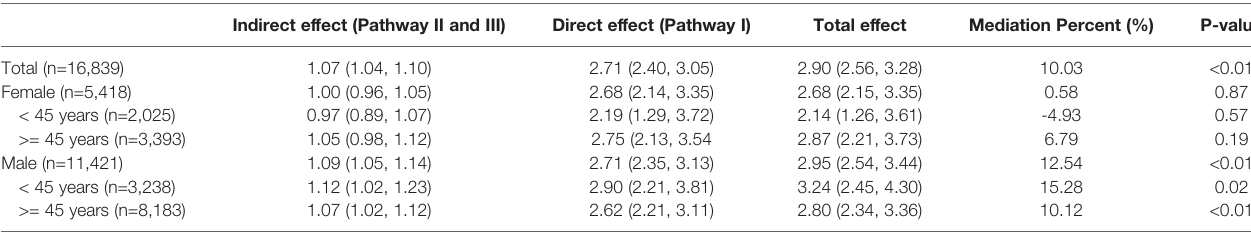
TABLE 5 | Mediation effect by SUA in the association between obesity and